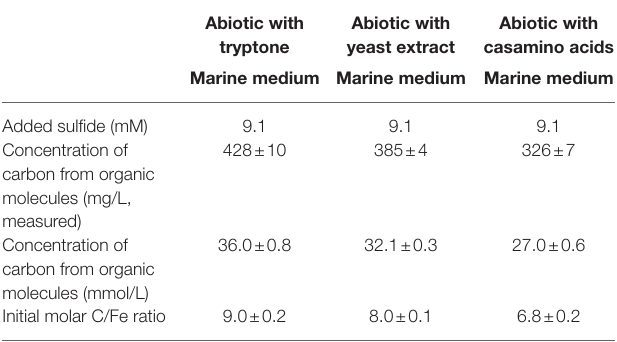
TABLE 2 | Summary of experimental conditions for abiotic experiments with organic